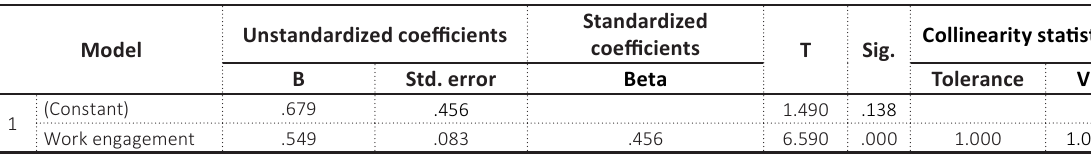
Table 6. Regression coefficients (extra effort and work